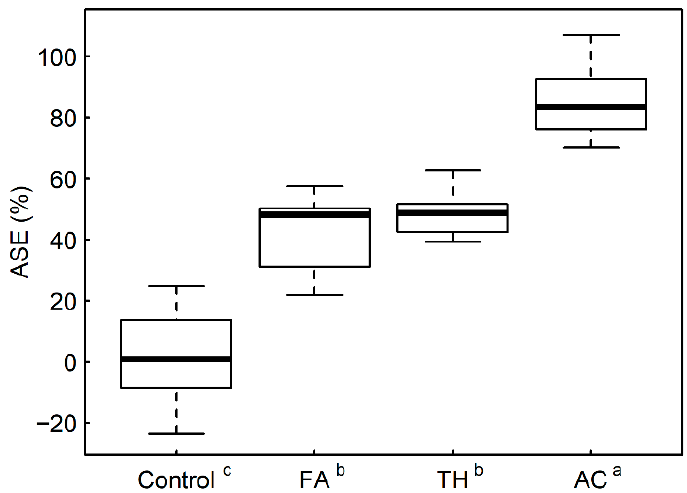
Figure 2. Anti-shrink efficiency values for each modification type (excluding the first water-soak oven-dry cycle). Superscripted letters on the x -axis indicate significant differences according to Tukey’s HSD test (95% confidence level).